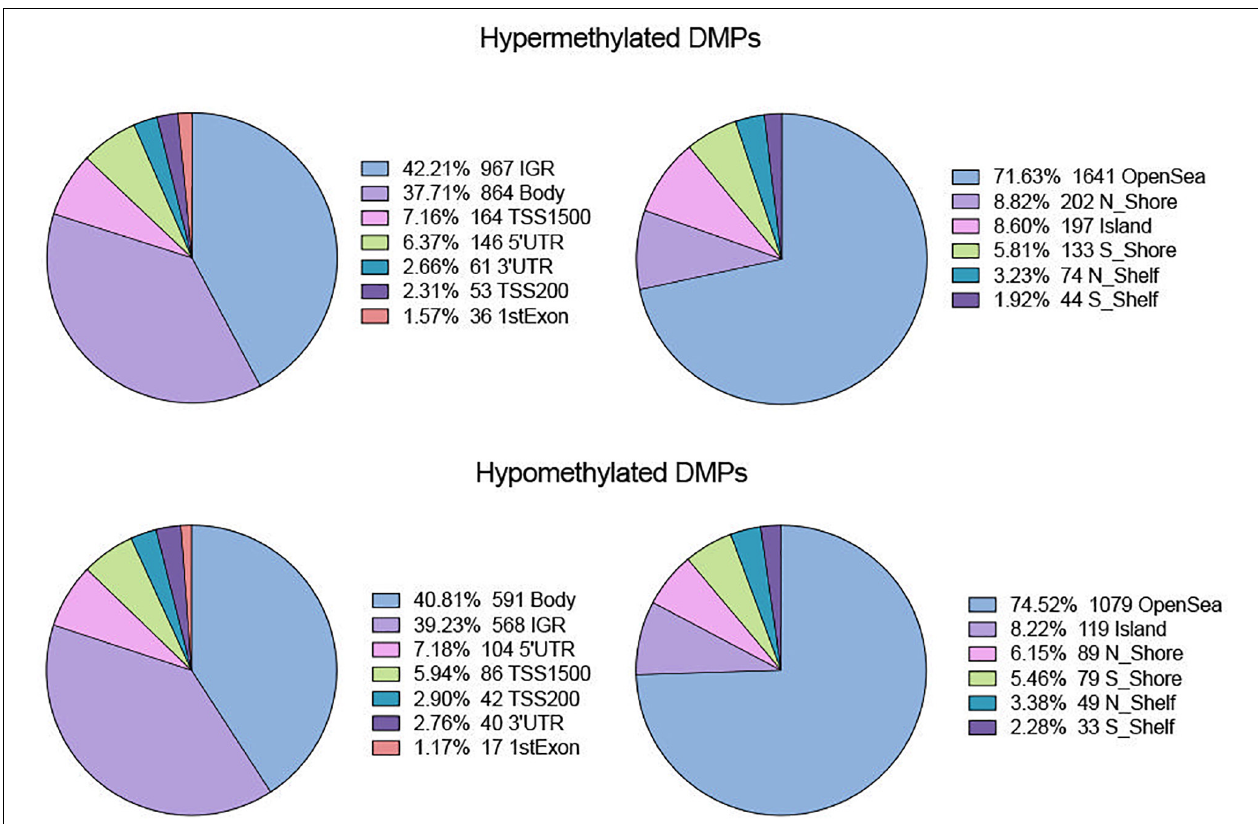
FIGURE 2 | Distribution of hyper- and hypo-DMPs across different categories of genomic feature. Pie chart separately reveals the precentage of DMPs enriched in different gene regions (IGR, Body, TSS 1500, TSS200, 5 (cid:48) UTR, 3 (cid:48) UTR, and 1stExon) as well as in regions relative to CpG Island (OpenSea, N_Shore, S_Shore, N_Shelf, S_Shelf, and Island).